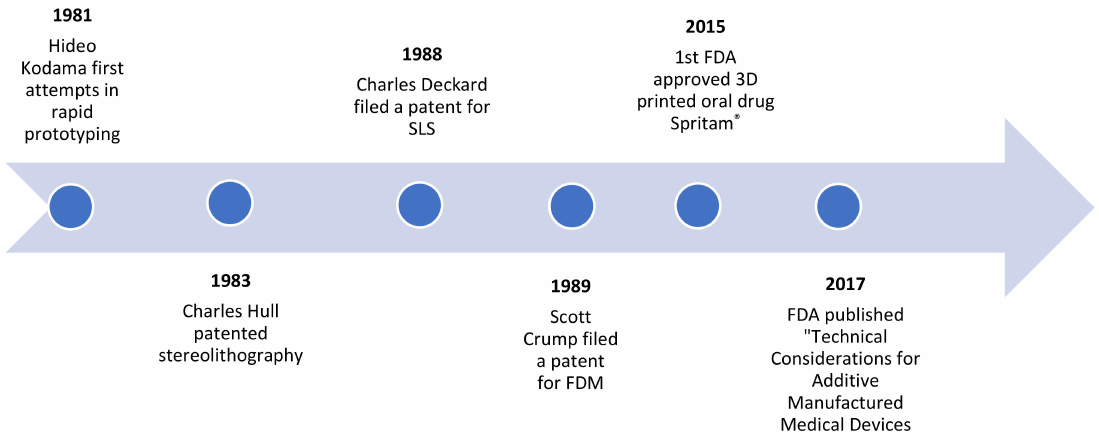
Figure 1. Historic timeline of